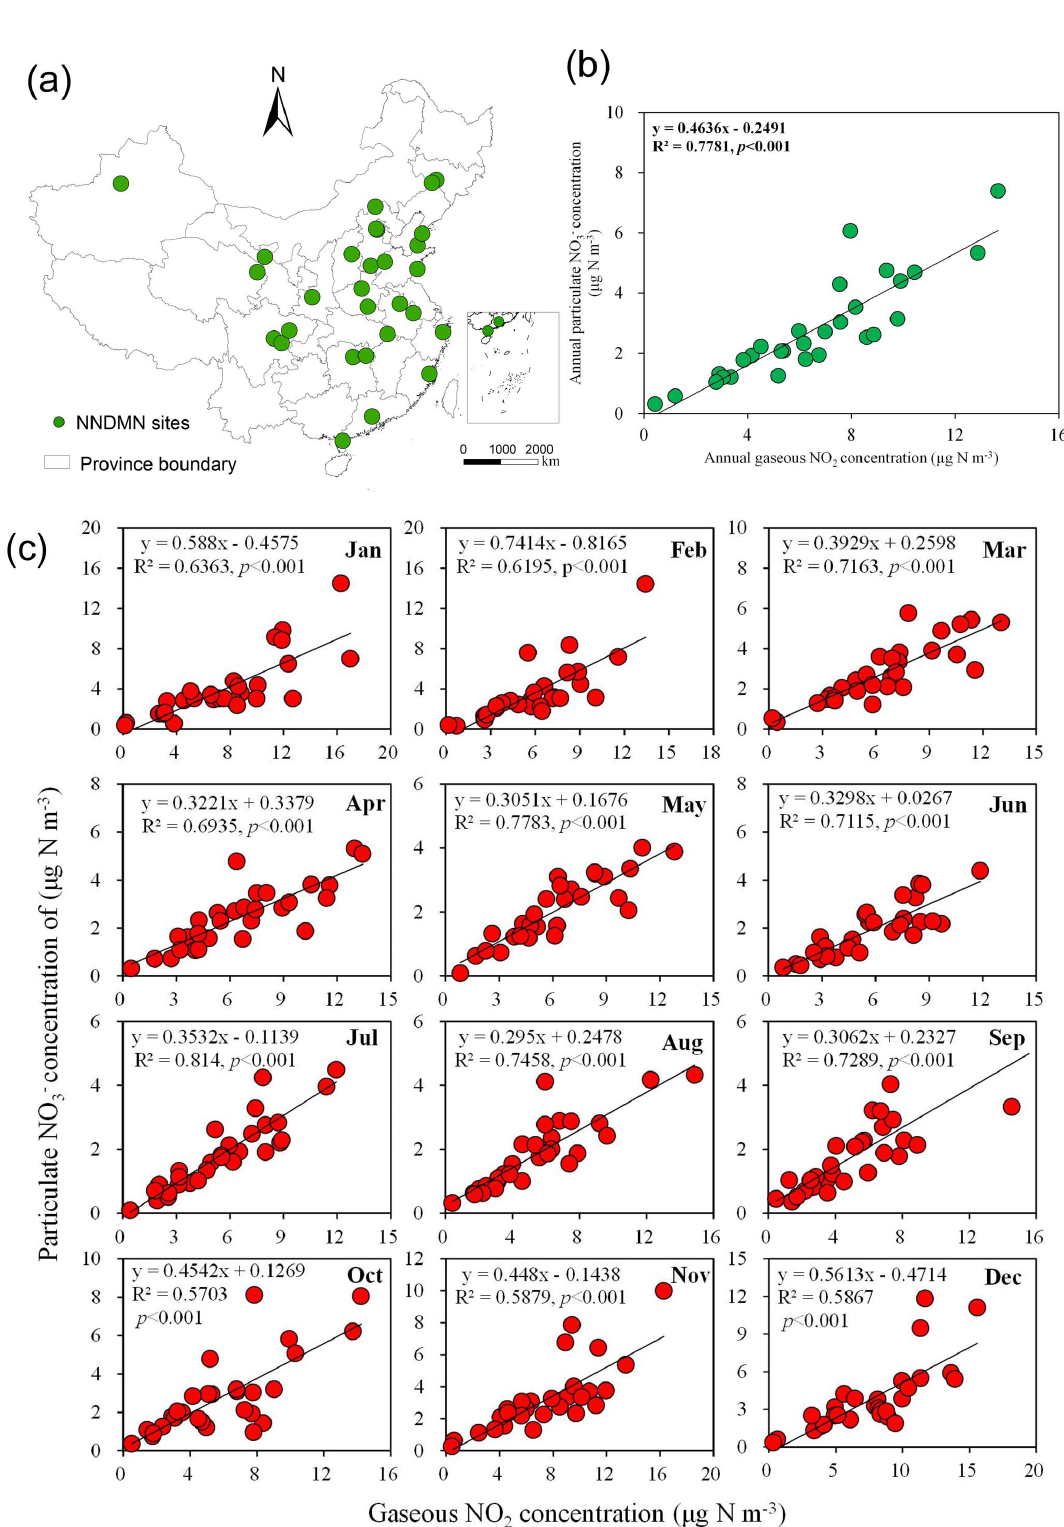
Figure 6. Correlation between surface NO 2 and particulate NO − adopted from our previous study (Liu et al., 2017c). (a) indicates the spatial locations of monitoring sites in the NNDMN; (b) and (c) represent yearly and monthly relationships between surface NO 2 and particulate NO −